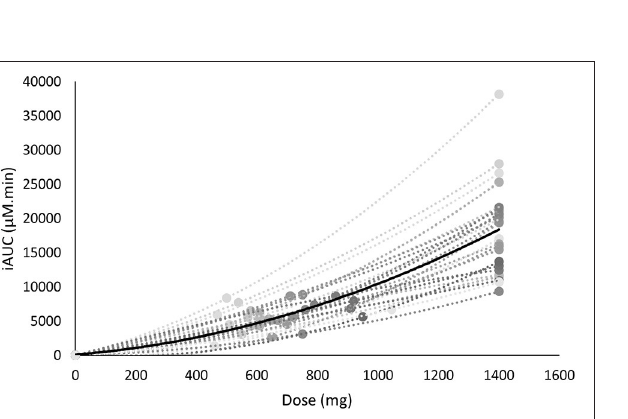
FIGURE 3 | A positive correlation is found between the iAUC of the weight-relative dose and the anthropometric characteristics: body weight (BW) (A) , height (B) , resting metabolic rate (RMR) (C) , and BMI (D) .